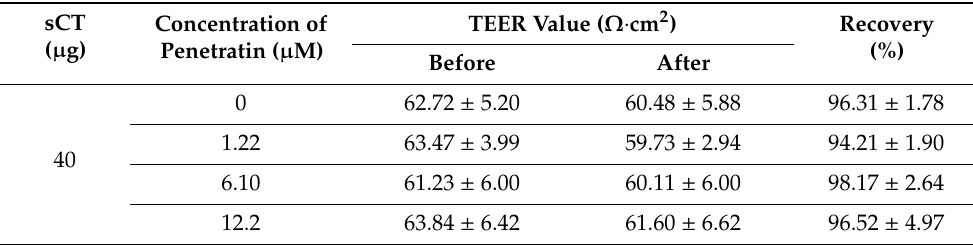
Table 2. TEER value for formulations before and after permeability experiments through TR146 cell layers.